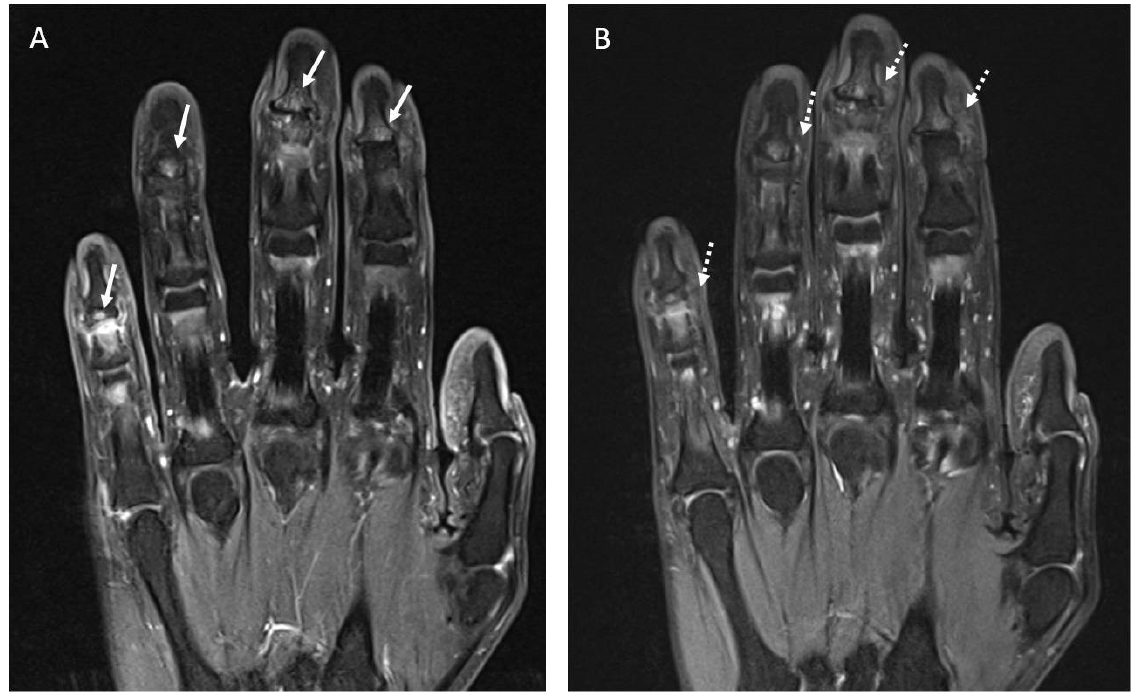
Figure 5. ( A ). Coronal fat suppressed T1-weighted image of the hand following IV